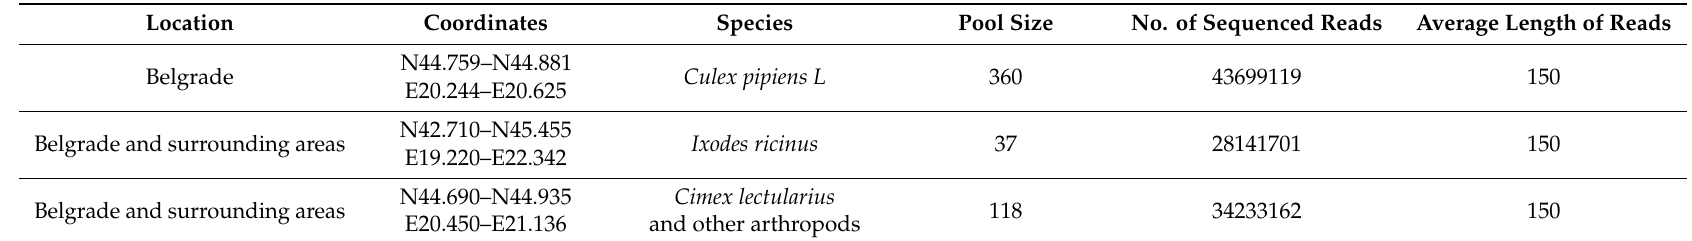
Table 1. Summary of the sampling sites, species and sequenced data.